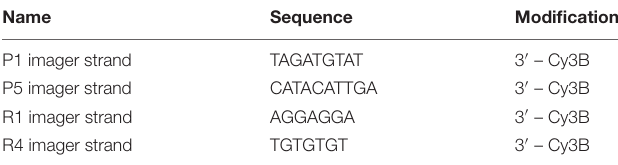
TABLE 2 | Sequences of imager